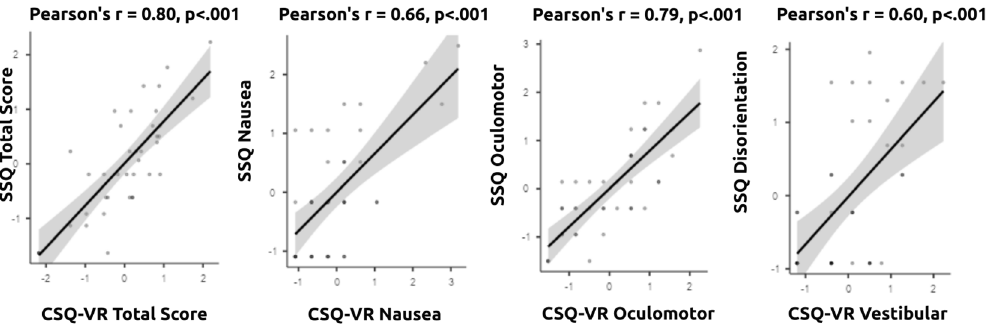
Figure 4. Correlations between the scores of the CSQ-VR (paper-and-pencil version) and the SSQ.